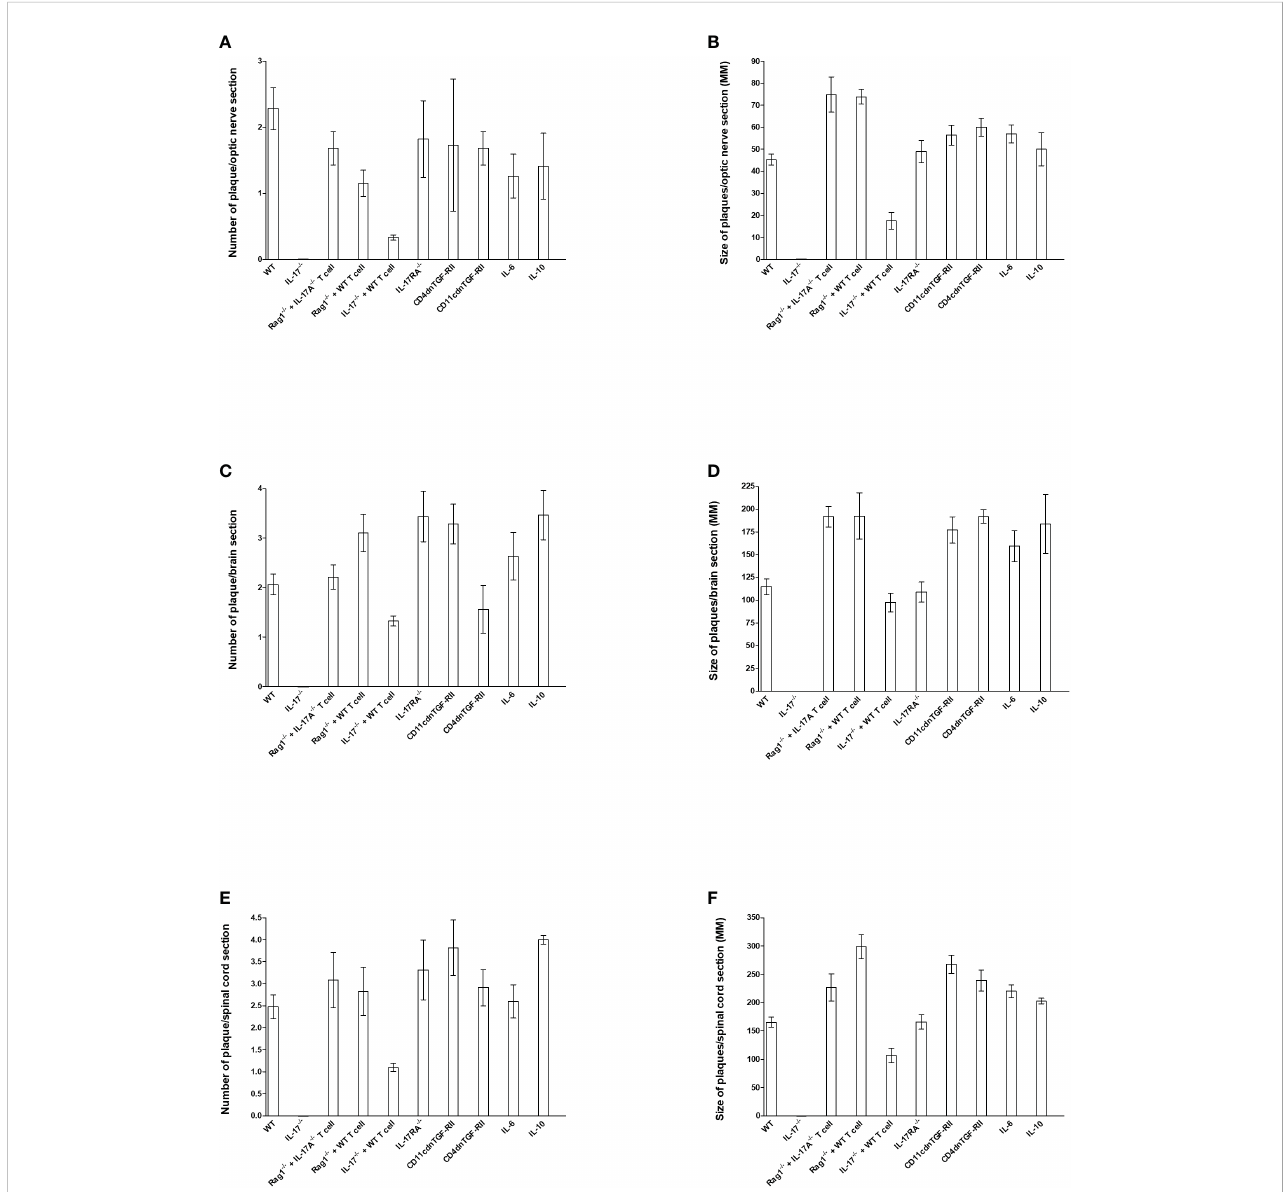
FIGURE 3 Number and size of demyelination plaques in CNS of infected HSV-IL-2 mice. The entire brain, spinal cord, and optic nerves of each of the 5 animals described in Figures 1, 2, 4 – 6 were sectioned and every 5th slide of each tissue was stained. The number (A, C, E) and size of (B, D, F) demyelination plaques in the entire sections of brain, spinal cord (E, F) and optic nerves (A, B) were counted and measured, respectively. Data are presented as number of plaques per total sections or size of plaques per total sections. Data are presented as mean number of demyelination plaques or mean of size of demyelination plaques using a total of 150 sections for brain and spinal cord and 30 sections for optic nerve from 5 mice per